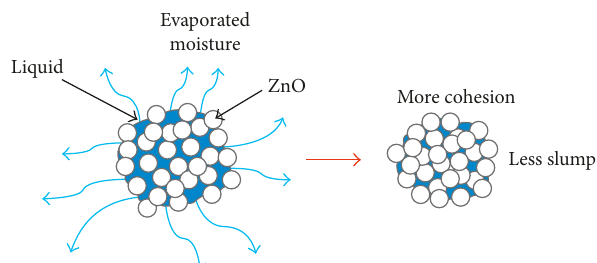
Figure 9: Slumping mechanism of the SAC0307-xZnO solders at 150 ° C.